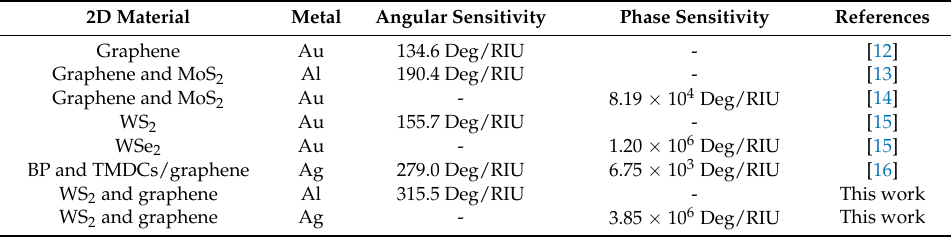
Table 4. Comparison with the formerly reported 2D-material-assisted SPR sensors.